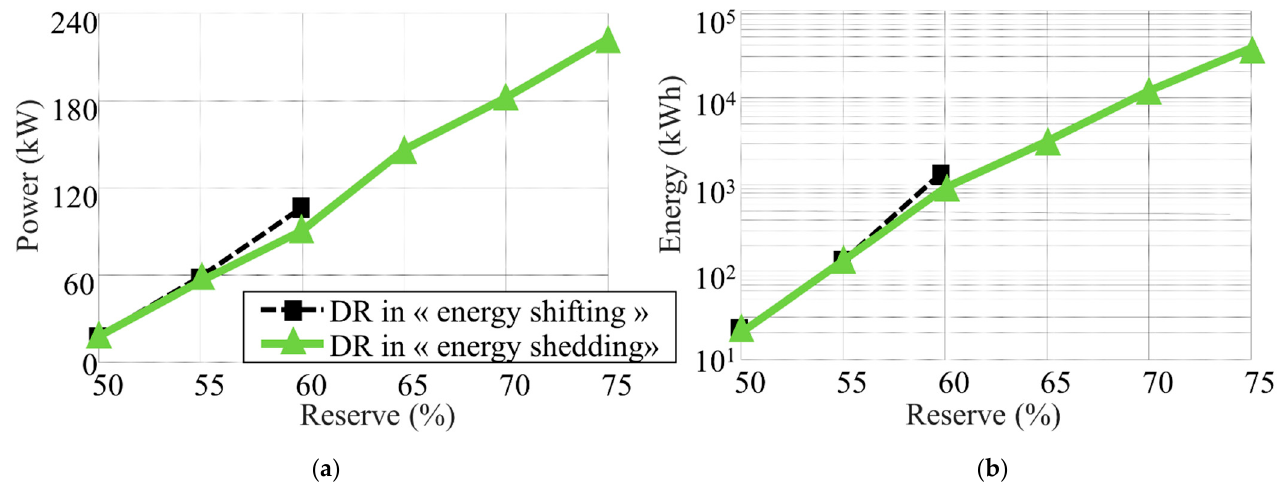
Figure 17. Results: DR modeled with or without payback effect/energy conservation: (a) DR power in kW; (b) DR energy in kWh.